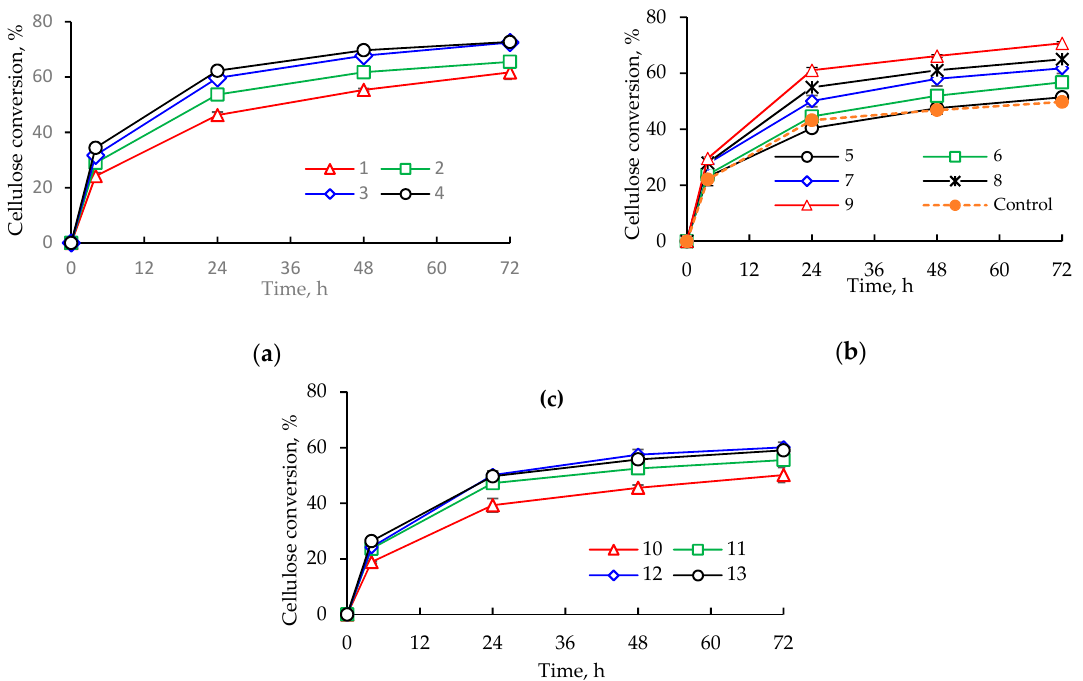
Figure 2. Time course of the enzymatic hydrolysis of steam-pretreated spruce at substrate loadings of 5% ( a ), 10% ( b ), and 15% ( c ). The numbers in the legend correspond to the experimental reactions as indicated in Table 2. Mean of three replicates. The error bars correspond to standard deviations.